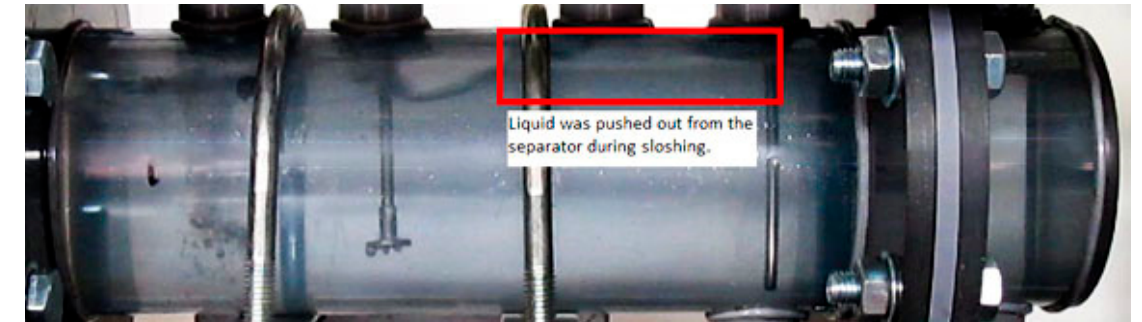
Figure 6. Sloshing in the Separator.